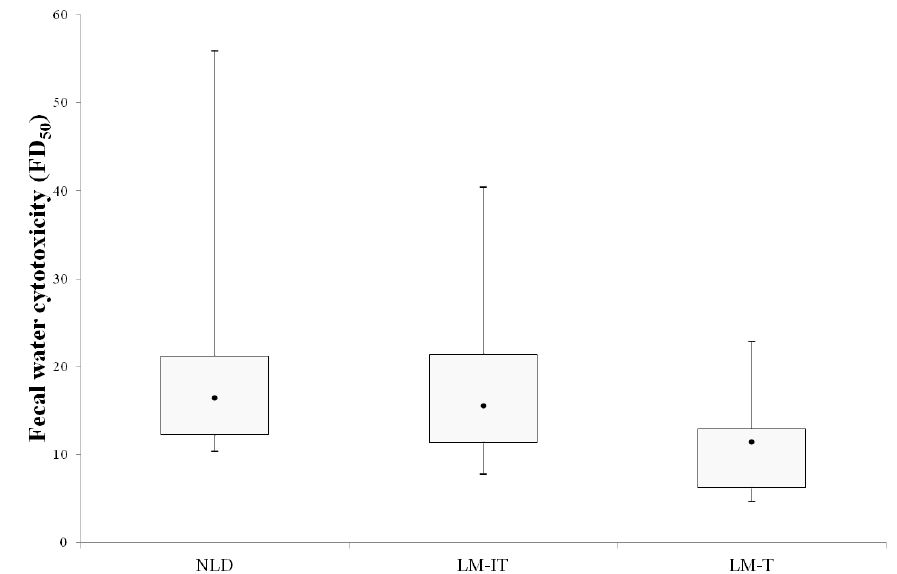
Figure 1. Fecal water toxicity in LM-IT, LM-T and NLD (median (Interquartile Range (IQR))) expressed as the fold dilution at which half of the cells died (FD 50 ). NLD: normal lactose digestion; LM-IT: lactose malabsorption with abdominal complaints; LM-T: lactose malabsorption with without abdominal complaints.